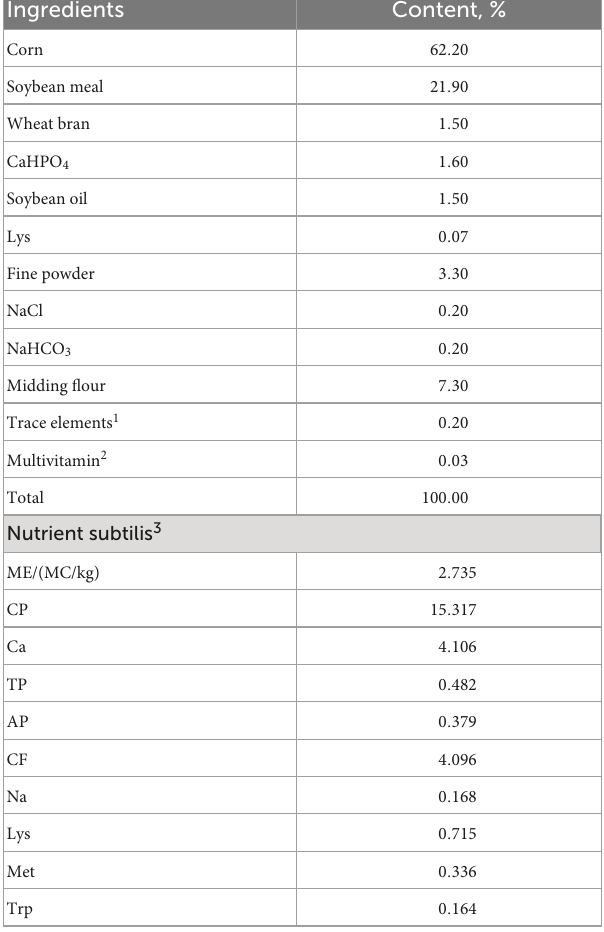
TABLE 1 Ingredients and chemical composition of basal